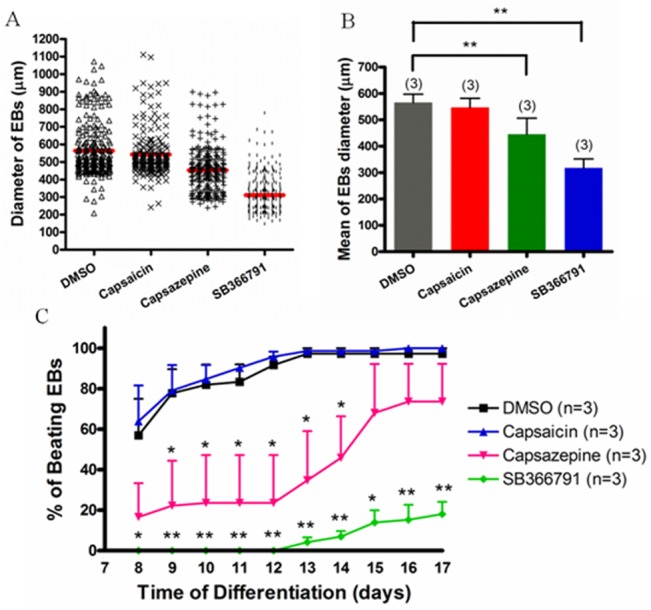
Effect of TRPV1 agonist or antagonists on EB sizes and EB beating curves.(A) (A) Summary of data illustrating EB size distribution on the differentiation day 7 after treatment with 0.1% DMSO (vehicle control), 1 μM capsaicin, 10 μM capsazepine, or 10 μM SB366791. Each group contained more than 200 EBs from 3 independent experiments, with red bar representing the average size. (B) Data summary of EB sizes under different treatments. (C) The percentage of beating EBs after different treatments. The beating was recorded from differentiation day 8 to day 17. Results were Mean ± SEM. n = 3 experiments. * P < 0.05, ** P < 0.01 compared to DMSO control.